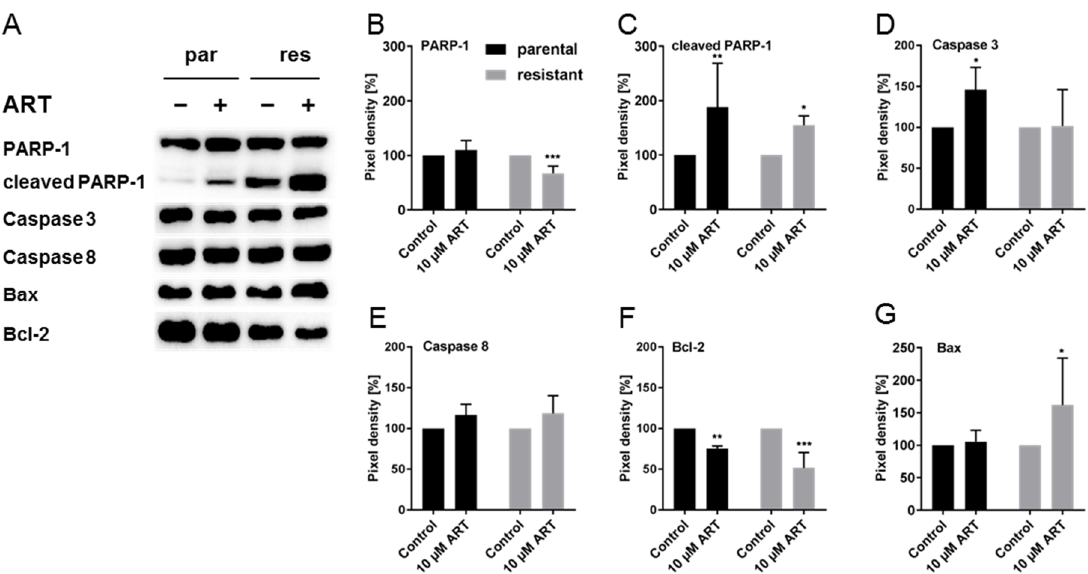
Figure 6. Apoptosisand DNA damage repair associated proteins: Representative Western blot analysis of DNA damage repair and cell death associated proteins in parental (par) and cisplatin-resistant (res) T24 cells after 24 h exposure to 10 µM ART (PARP-1 = non-cleaved PARP-1) ( A ). Pixel density analysis of the protein expression ( B – G ), compared to the untreated controls (set to 100%) is illustrated. Each protein analysis was normalized by a total protein staining control. Error bars indicate standard deviation ( SD ). Significant difference to untreated control: * p ≤ 0.05, ** p ≤ 0.01, *** p ≤ 0.001. n = 4. For detailed information regarding the Western blots see Figure S2.